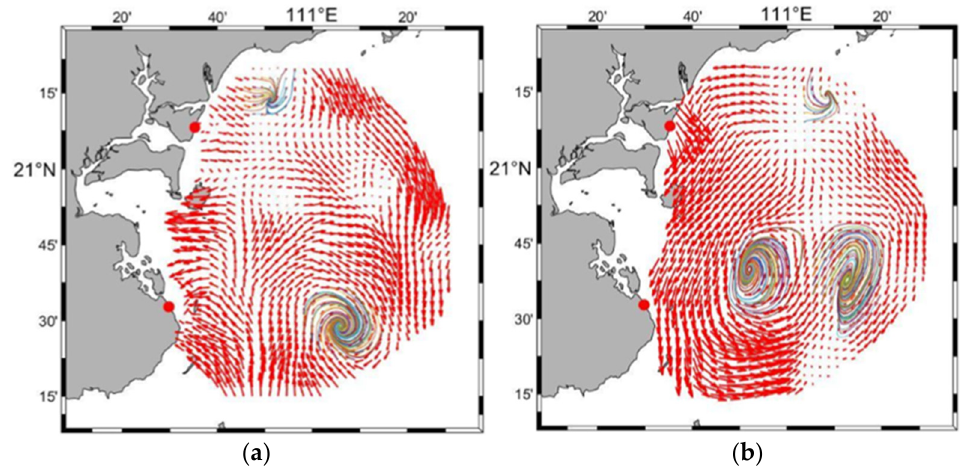
Figure 8. Special eddy situations. ( a ) Two eddies and ( b ) three eddies.